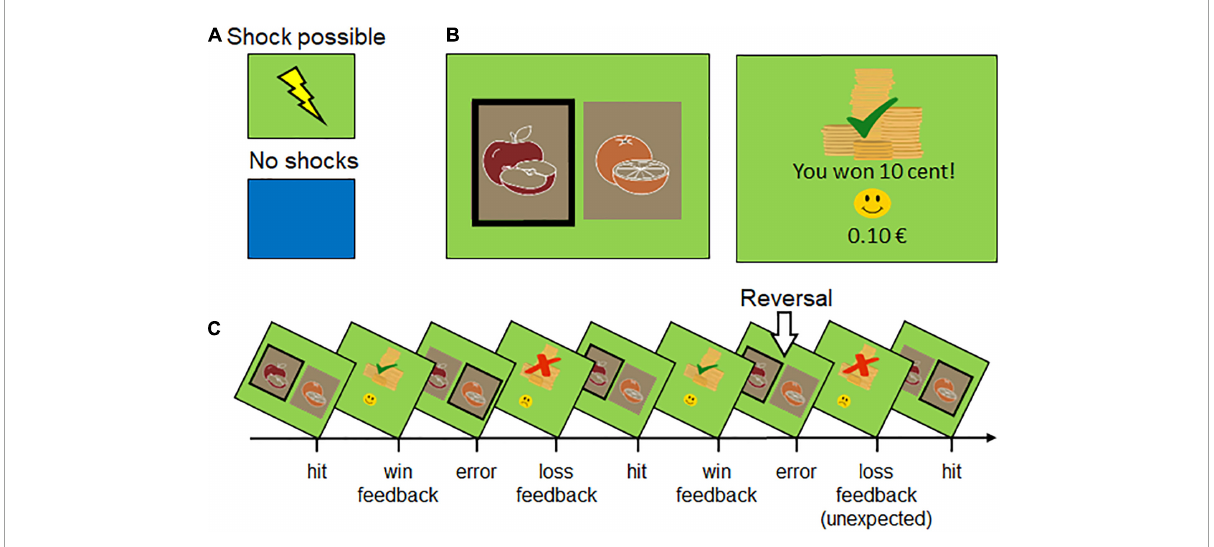
FIGURE1 Reward reversal learning as a function of instructed threat or safety. (A) Participants are verbally instructed to anticipate up to three unpleasant electric shocks when a specific background color is presented (e.g., green signals threat of shock, blue safety). As a reminder, a print-out of the assigned colors to threat or safety was fixed under the screen and presented on the screen before context conditions changed. (B) Participants’ task was to find out and select the rewarded stimulus (i.e., apples vs. oranges, blond vs. dark-haired female face). (C) Illustration of reward learning (i.e., apples are rewarded) and reward reversal (i.e., now oranges are rewarded). Errors can be congruent (due to wrong contingency) or incongruent (i.e., unexpected) due to newly changed